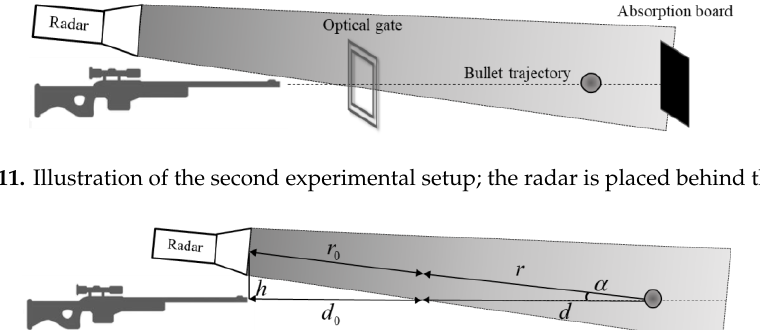
Figure 13. Measurement results: The intermediate frequency (IF) signal in the time domain.